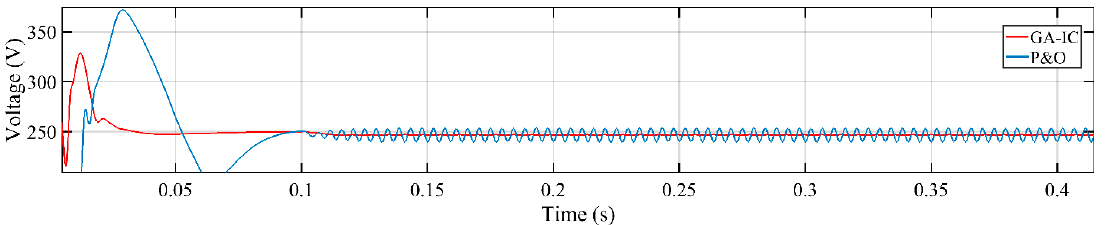
Figure 35. Case 3 voltage, detailed comparison of modified GA-IC vs. P&O.